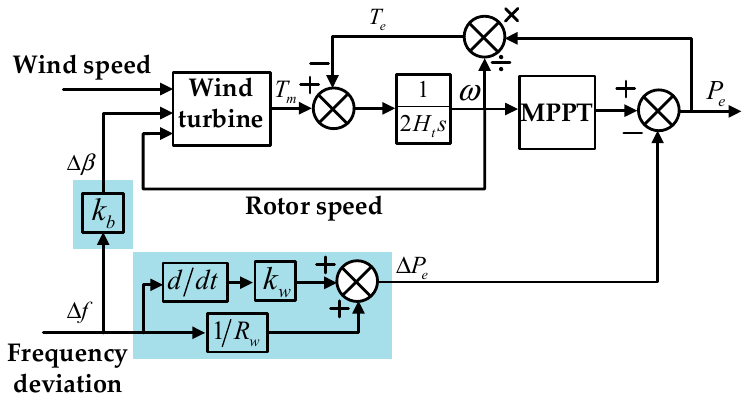
Figure 1. Frequency combination control strategy of wind turbine generators (WTGs).